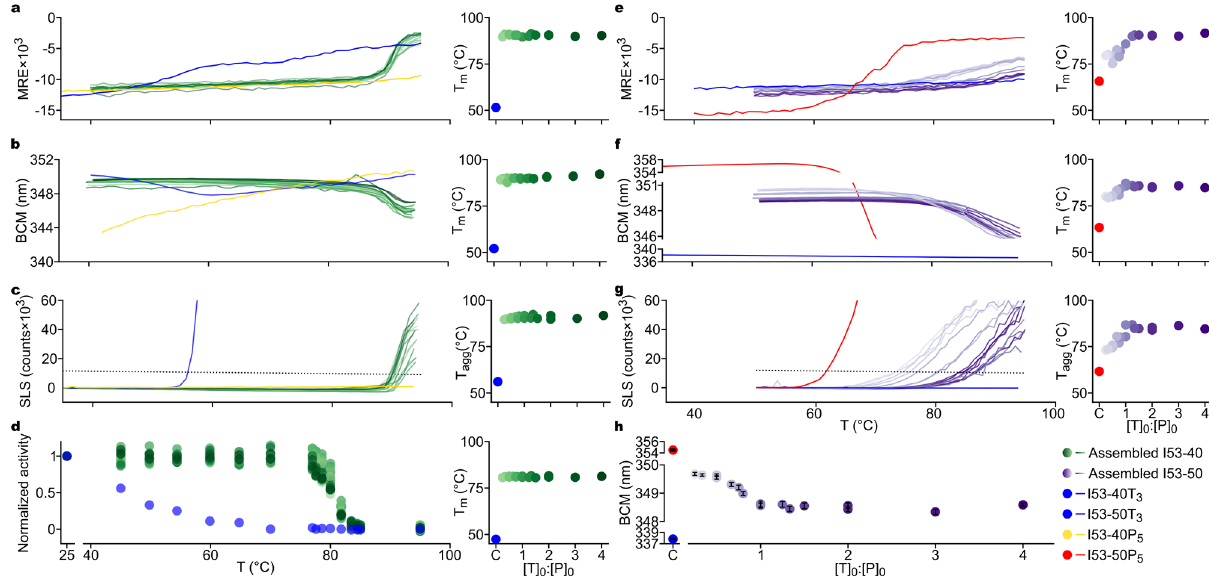
Fig. 3 Biochemical and biophysical characterization of nanomaterial stability and composition. Representative samples of SEC-puri fi ed I53-40 and I53- 50 were monitored by a , e CD reported as MRE (mean residue ellipticity; deg × cm 2 /dmol) at 222 nm; b , f intrinsic fl uorescence, plotted as the barycentric mean (BCM) of the emission spectrum; and c , g SLS as a function of temperature. d Aldolase activity in I53-40 and I53-40T 3 samples after incubation at selected temperatures for 1 h, normalized to activity in samples incubated at 25 °C. h Ambient temperature fl uorescence emission (average BCM) for SEC- puri fi ed I53-50 samples plotted as a function of [T] 0 :[P] 0 ratio. Error bars represent the standard deviation of fi ve scans. For all panels, marker and line saturation correlate with increasing [T] 0 :[P] 0 ratio at mixing, and adjacent dot plots track T m or T agg (determined by second derivative analysis or by the intersection of each trace with a de fi ned threshold; dotted lines) of each SEC-puri fi ed nanomaterial as a function of [T] 0 :[P] 0 ratio. Source data are provided as a Source Data fi